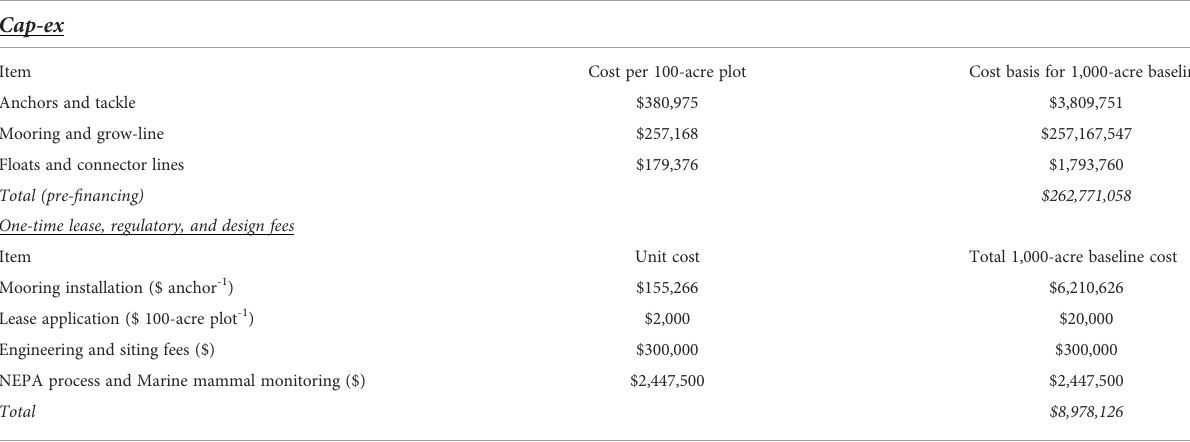
TABLE 1 Summary of costs included within the Initial Investment ( I 0 ) in the baseline